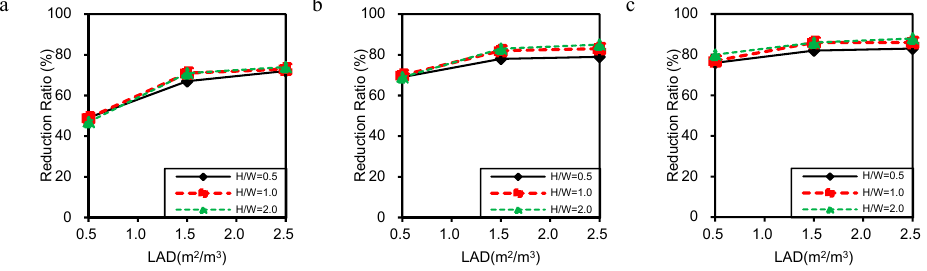
Figure 10. Reduction ratio at z = 1.5 m in average PM 2.5 for conical ( a ), spherical ( b ), and cylindrical ( c ) canopies.